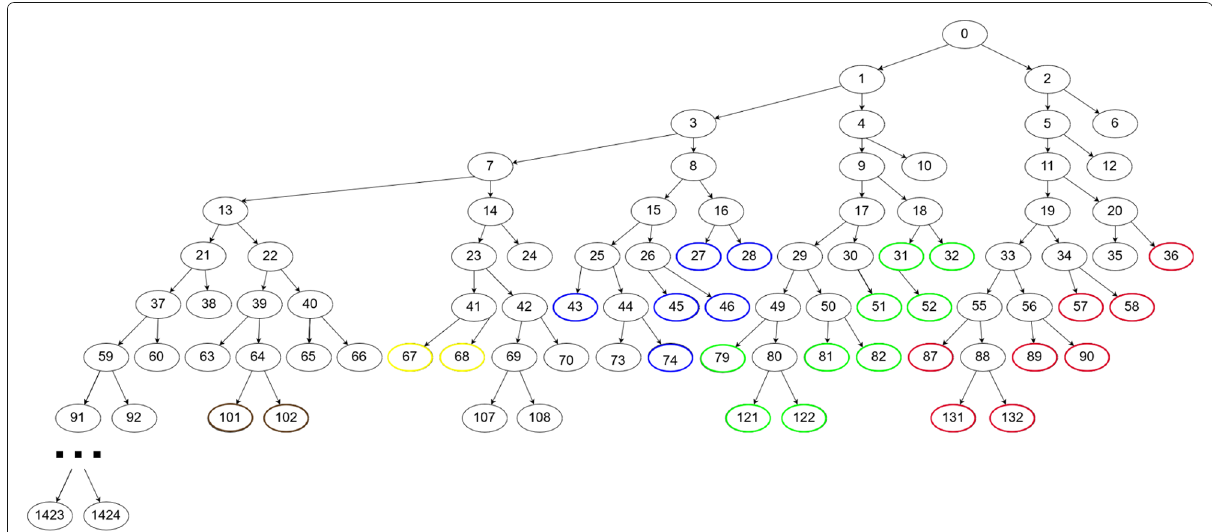
Fig. 5 The binary tree of the NYTimes dataset. The most similar leaf clusters that was discovered during the graph construction module are presented using the same colors and the clustered graphs. Evidently, most of the big clus- ters do not have similarities with other clusters, but some